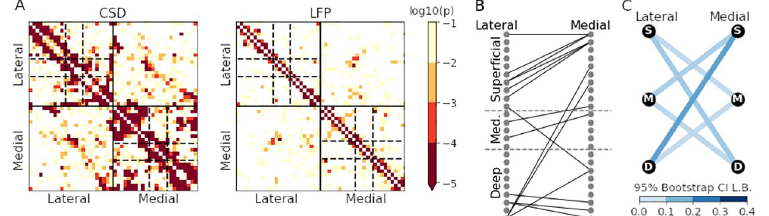
Fig 3. Phase coupling graphs in auditory CSD and LFP. (A) Results of edgewise torus graph phase coupling inference both within- and across-probe for CSD (left) and LFP (right); depth along each probe is increasing left to right and top to bottom, and dashed lines indicate approximate boundaries between superficial, medium, and deep cortical layers. Colored entries correspond to edges, with color representing the log 10 of the p -value. Within-probe, the LFP had edges primarily along the diagonal, while the CSD contained more edges, including some connections across superficial, medium, and deep layers. Between probes, the CSD torus graph contained a noticeable set of edges, primarily along the diagonal, while the LFP torus graph had very few edges between probes. (B) Graph showing significant between-probe CSD torus graph edges, with lateral probe nodes ordered by depth in the left column and medial probe nodes ordered by depth in the right column; dashed lines indicate approximate boundaries between superficial, medium, and deep cortical layers. Many of the cross-probe connections occurred near the same depth on both probes, though there appear to be some edges connecting lateral probe deep layers to medial probe superficial layers. (C) Simplified graph between superficial (S), medium (M), and deep (D) cortical layers. Edge color corresponds to a 95% bootstrap confidence interval lower bound for the partial PLV value (reflecting coupling strength, which falls between 0 and 1). The strongest cross-probe connection was between the deep layers of the lateral probe and the superficial layers of the medial